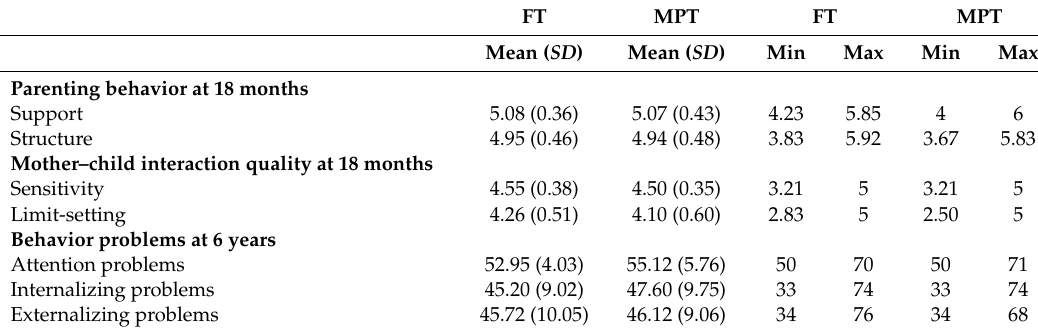
Table 2. Means, standard deviations, and range for all variables.